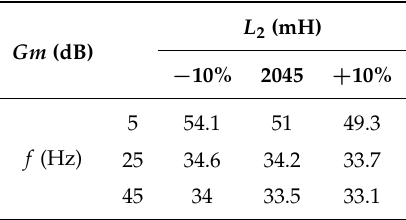
Table 3. Gain margin at different parameters of the system.